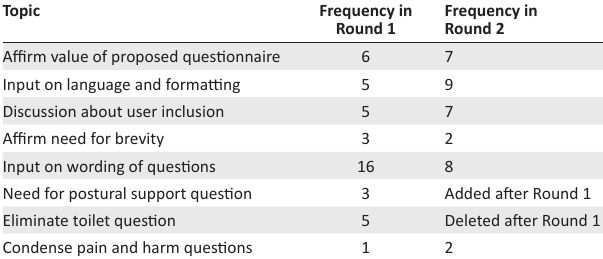
TABLE 3: The frequency of comments by